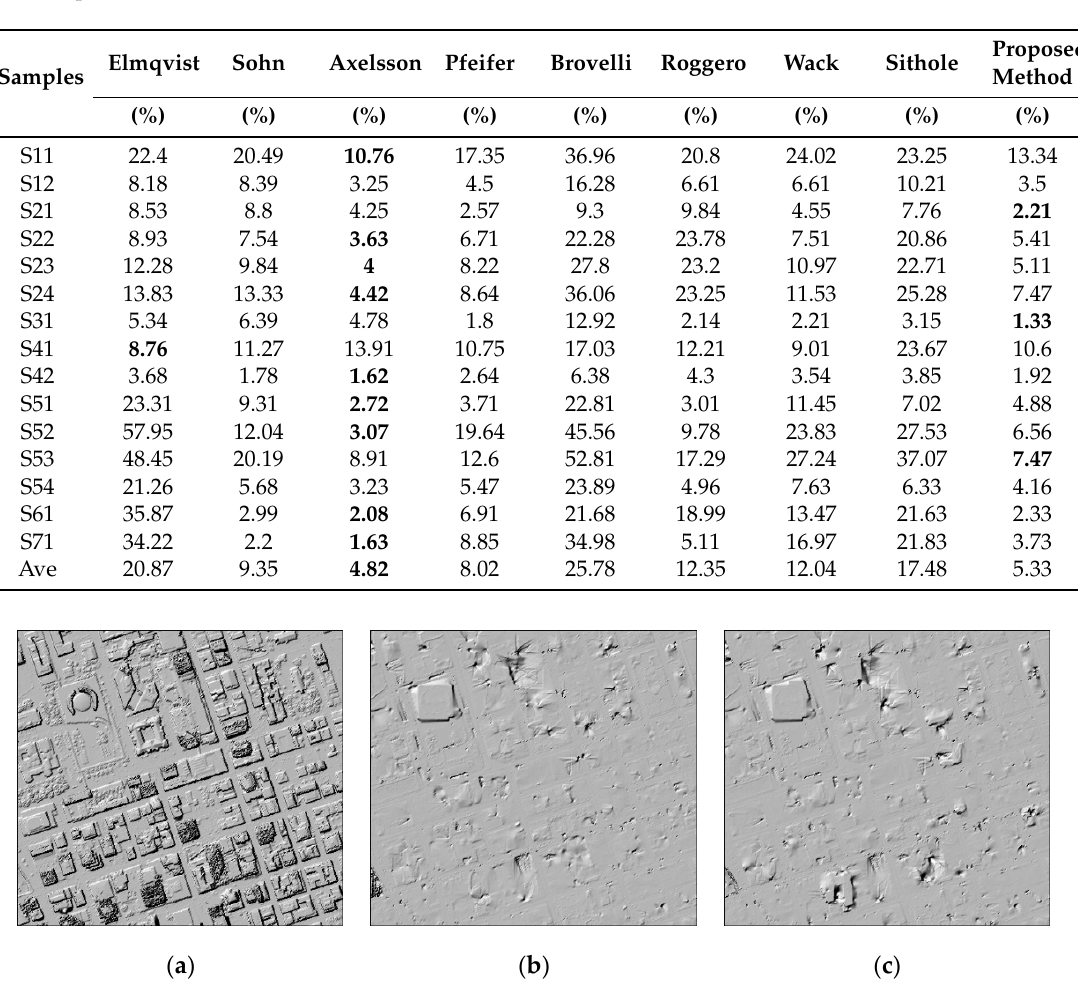
Figure 8. Filtering result: ( a ) the DSM before filtering; ( b ) the true DEM generated from the true ground points; and ( c ) the filtered DEM generated from the ground points derived by the proposed filtering algorithm.